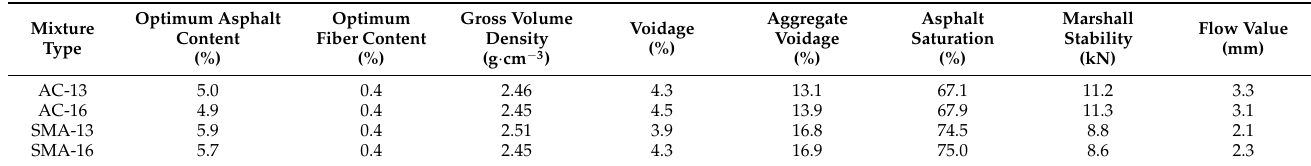
Table 5. Mix design data of each asphalt mixture.